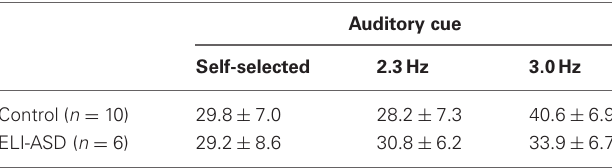
Table 2 | Effective leg stiffness (kN · m − 1 ) for Control and ELI-ASD groups. [Mean ±